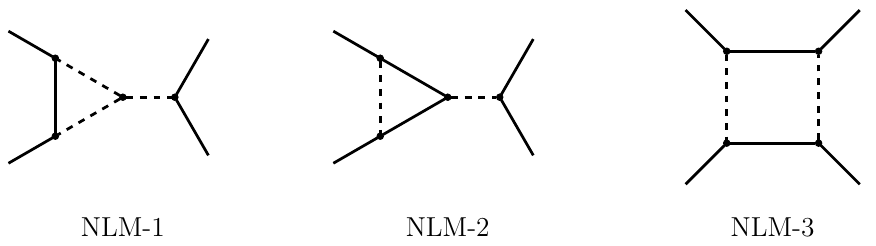
Figure 6 . The genuine one-loop diagrams for long-range 0 νββ decay in the mass basis. Notice that the external leg of Higgs is removed after electroweak symmetry breaking.